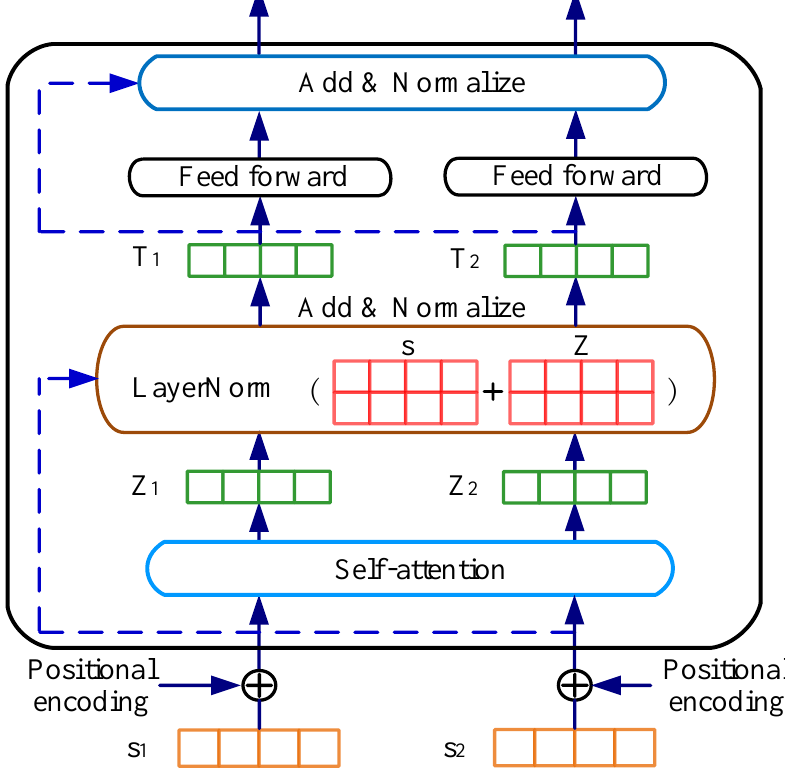
Figure 7. Basic structure of the transformer